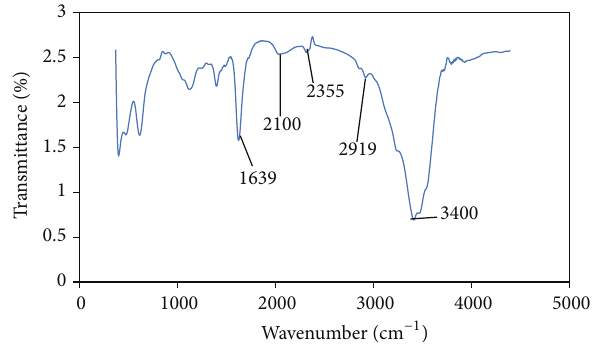
Figure 4: FTIR spectrum of pinewood.